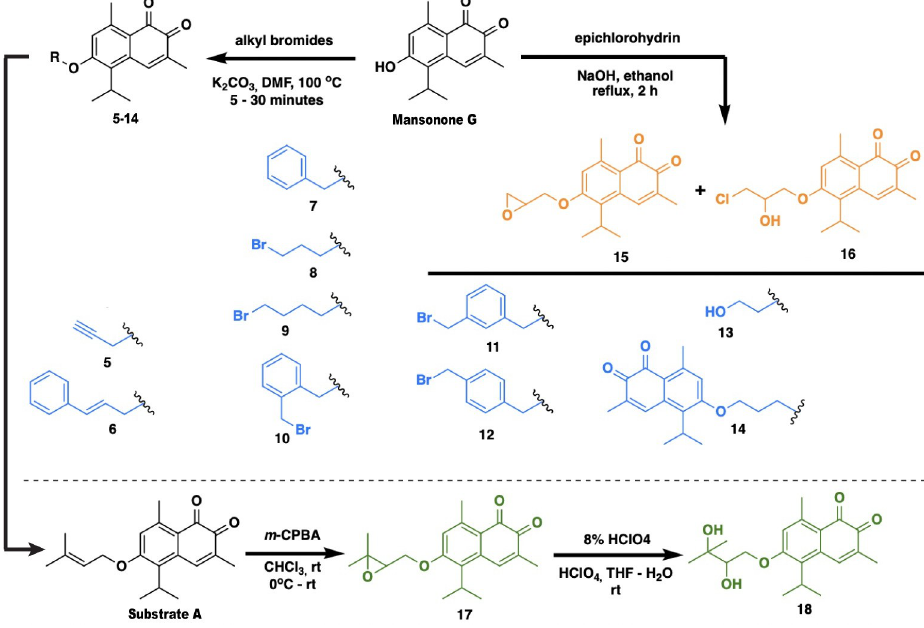
Fig 1. Schematics showing general procedure to synthesize ether derivatives of mansonone